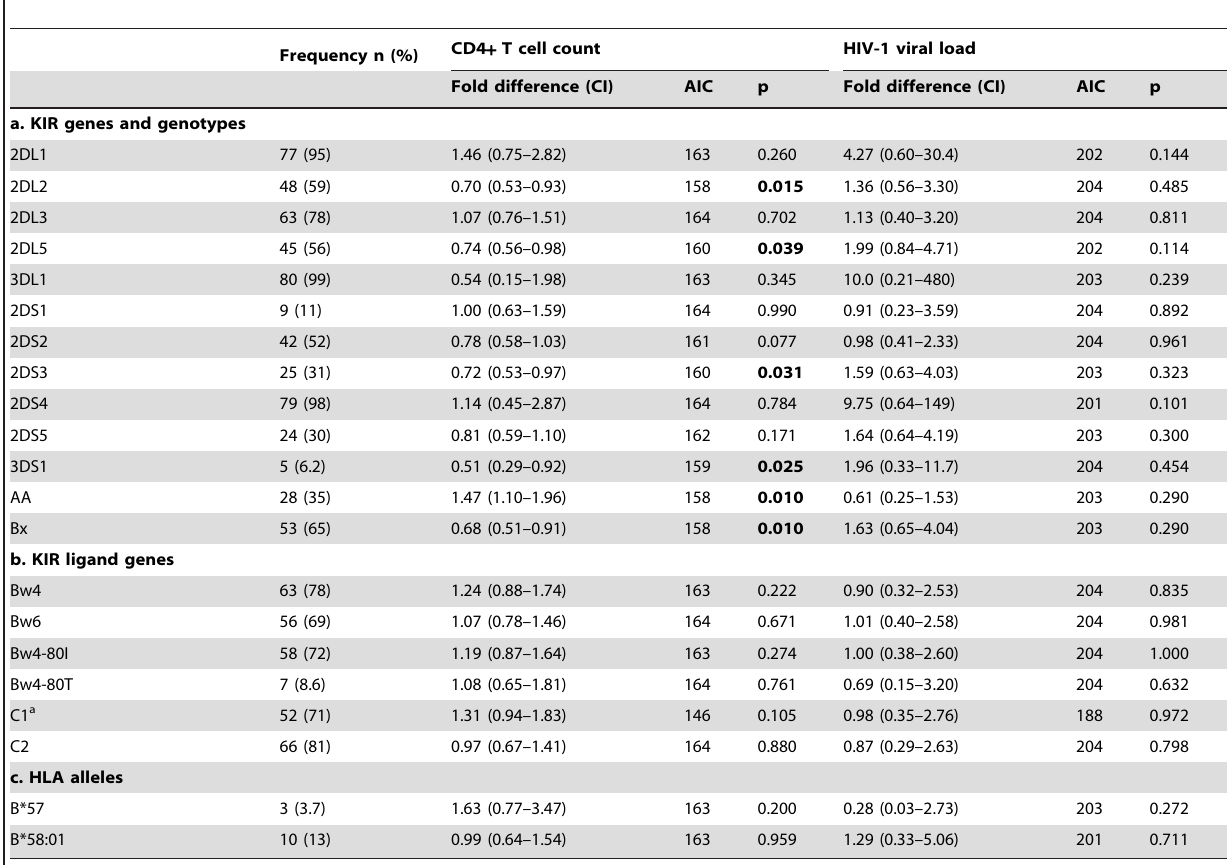
Table 1. Univariate effects of KIR and HLA genes on the CD4 + T cell count and HIV-1 viral load level of 81 HIV-1 infected